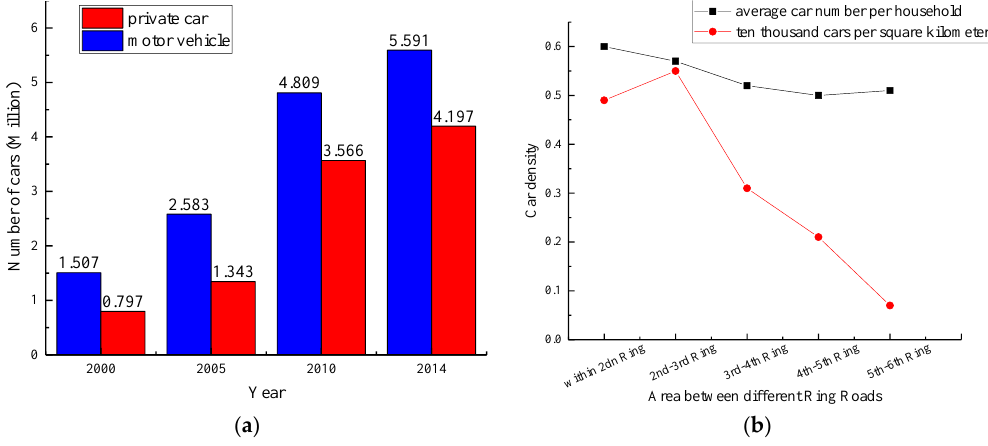
Figure 7. ( a ) Annual variation of cars and ( b ) spatial variation of cars with distance from ring roads in 2014.